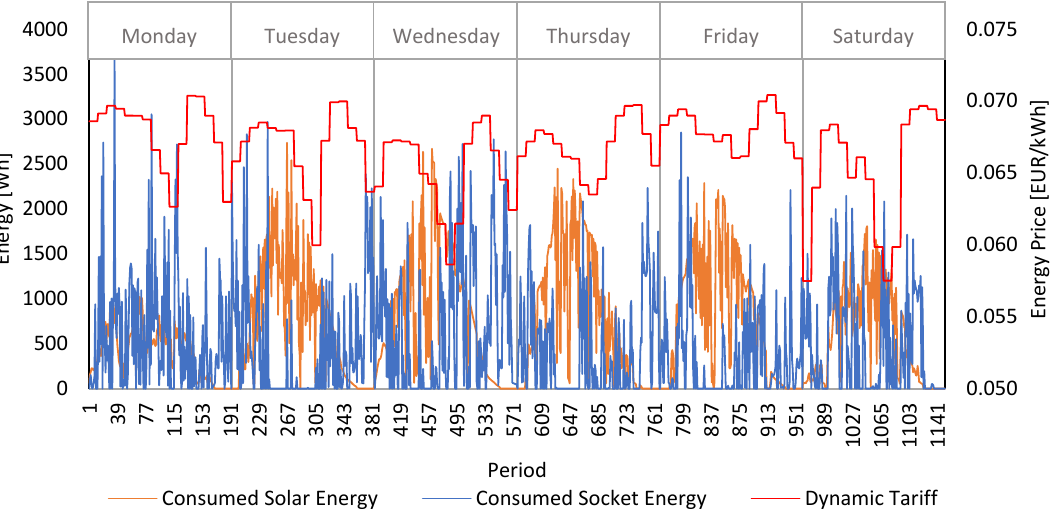
Figure 7. Gantt diagram of the scheduled plan.